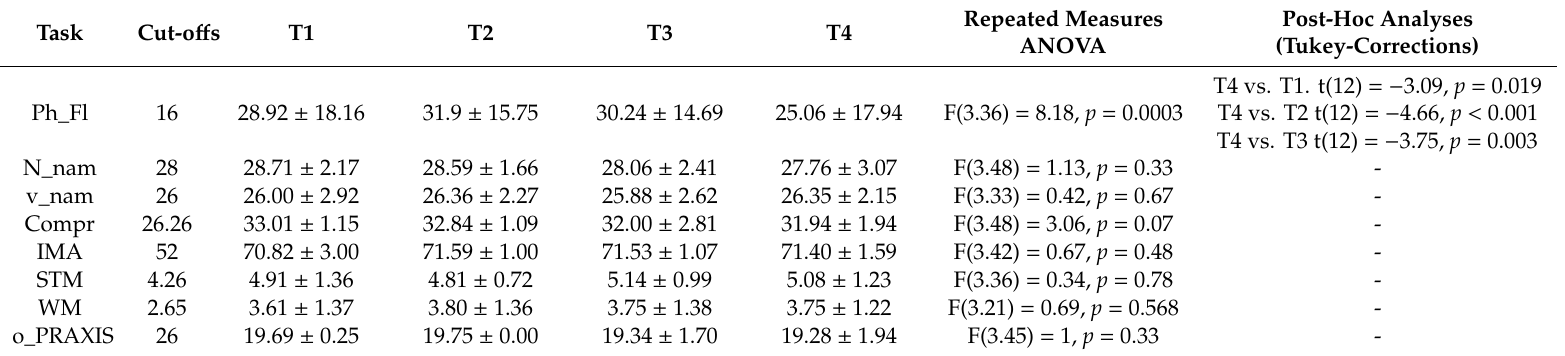
Table 6. Repeated measures ANOVA results for patients’ level of performance in various tasks pre- and post-first surgery (T1 and T2, respectively) and pre- and post-recurrence surgery (T3 and T4,